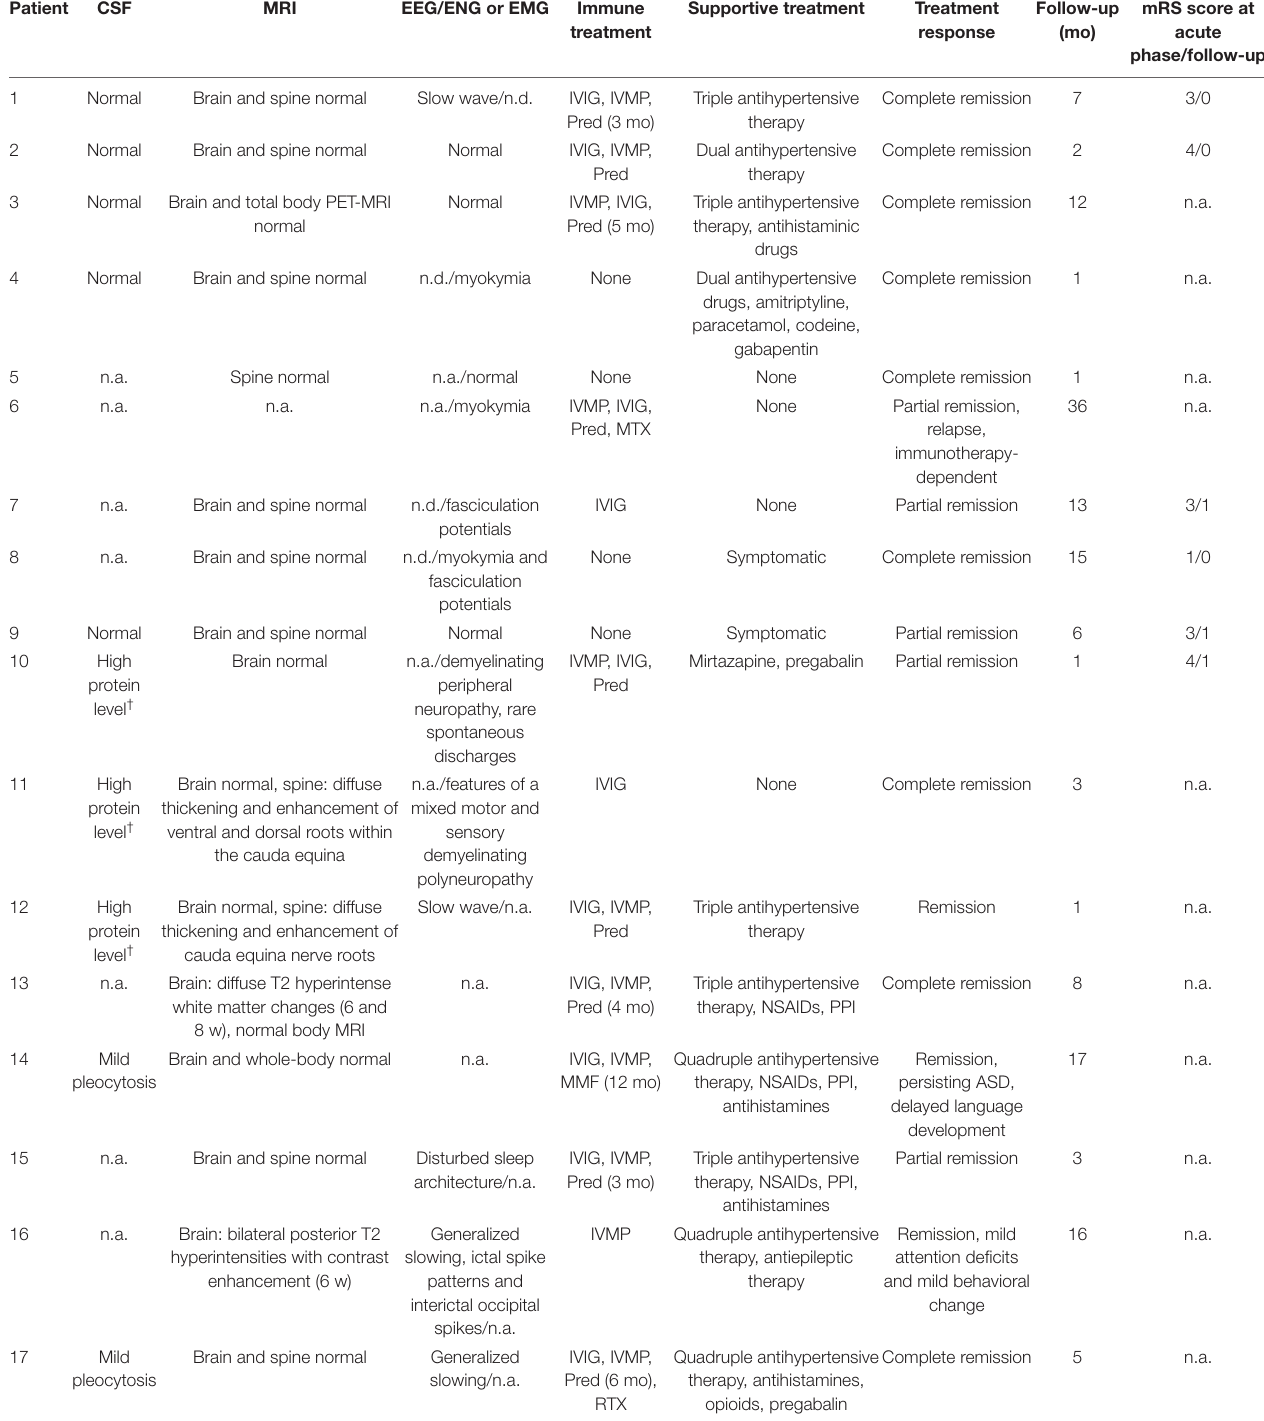
TABLE 2 | Investigations and immunotherapy in pediatric patients associated with double antibody-positive (LGI1 and CASPR2). Patient CSF Treatment